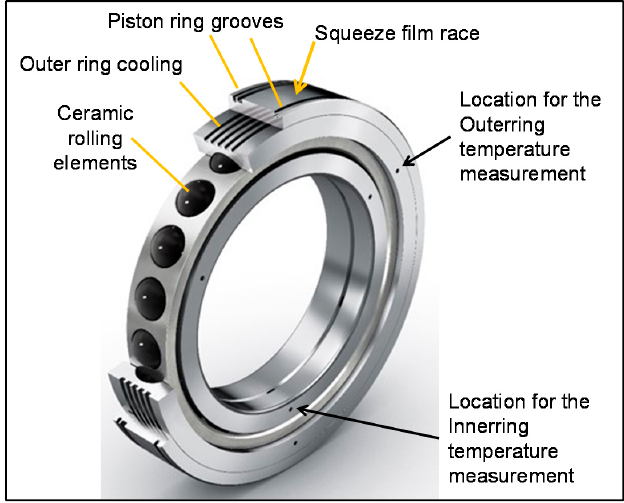
Figure 3. Details of the hybrid bearing arrangement with outer ring cooling and squeeze film damping. Table 1. Design details of the bearings.